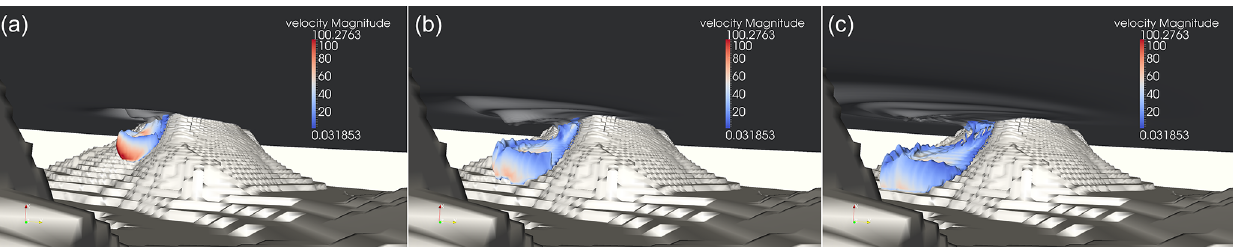
Figure 10. THETIS 3D computations for 80km 3 slide volume. Snapshots of a 0.1 slide volume fraction contour colored by velocity magni- tude at t = 100s (a) , 200s (b) and 300s (c) . Inviscid slide from Abadie et al. (2012).